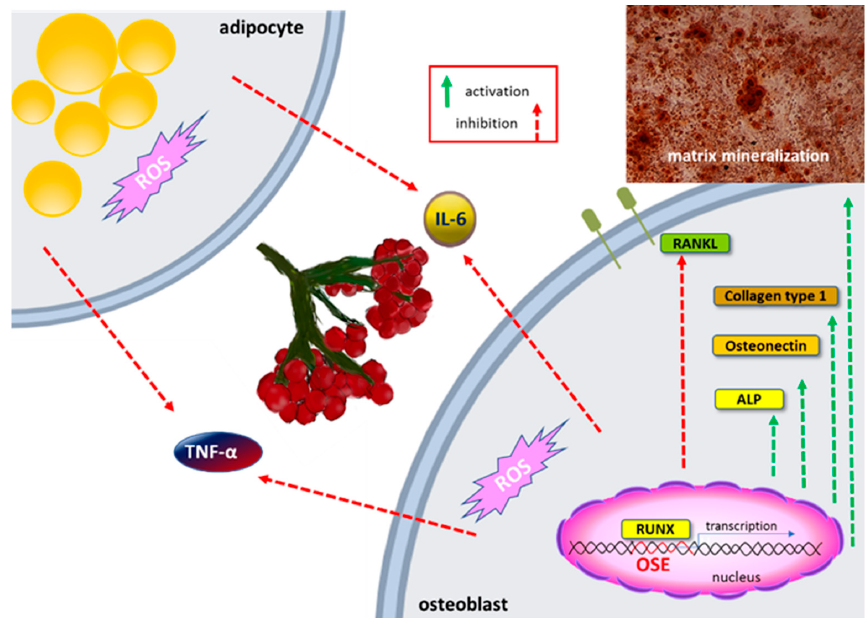
Figure 4. The proposed influence of Viburnum opulus on reduction of inflammatory response and regulation of osteogenesis process; see the main text for more details. ALP—alkaline phosphatase; IL-6—interleukin 6; OSE—osteoblast-specific cis-acting element; TNF- α —tumor necrosis factor α ; RANKL—receptor activator of nuclear factor-kB ligand; RUNX—Runt-related transcription factor.